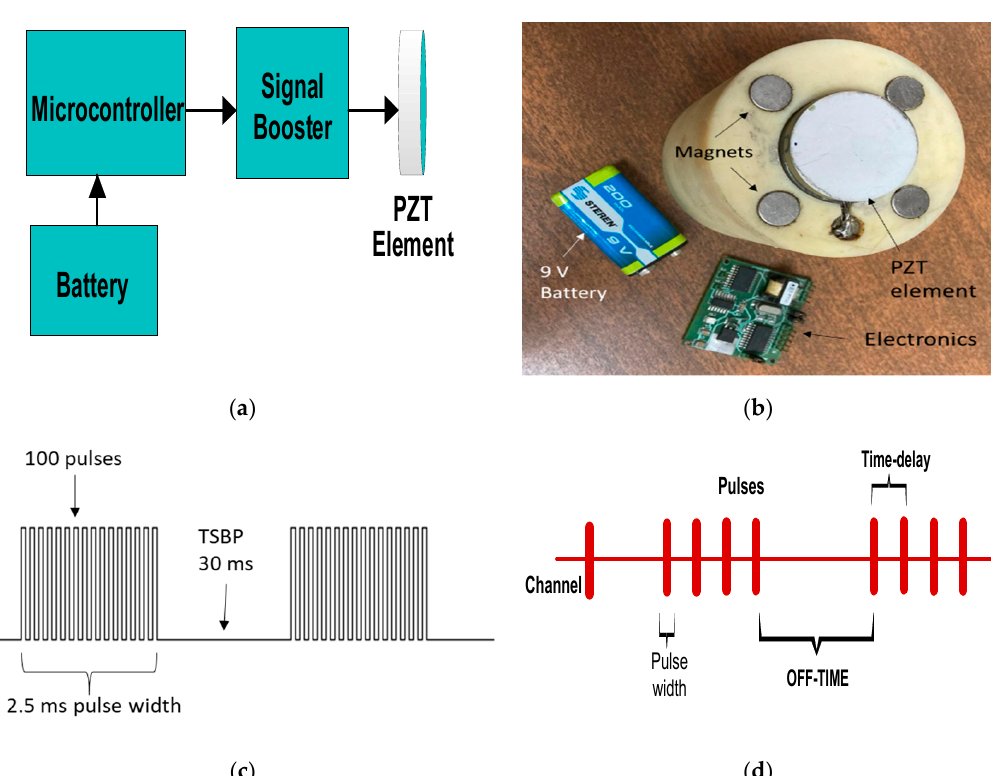
Figure 4. ( a ) PPM transmitter main components; ( b ) actual PPM transmitter design; ( c ) PPM pulse width; ( d ) PPM communication scheme.